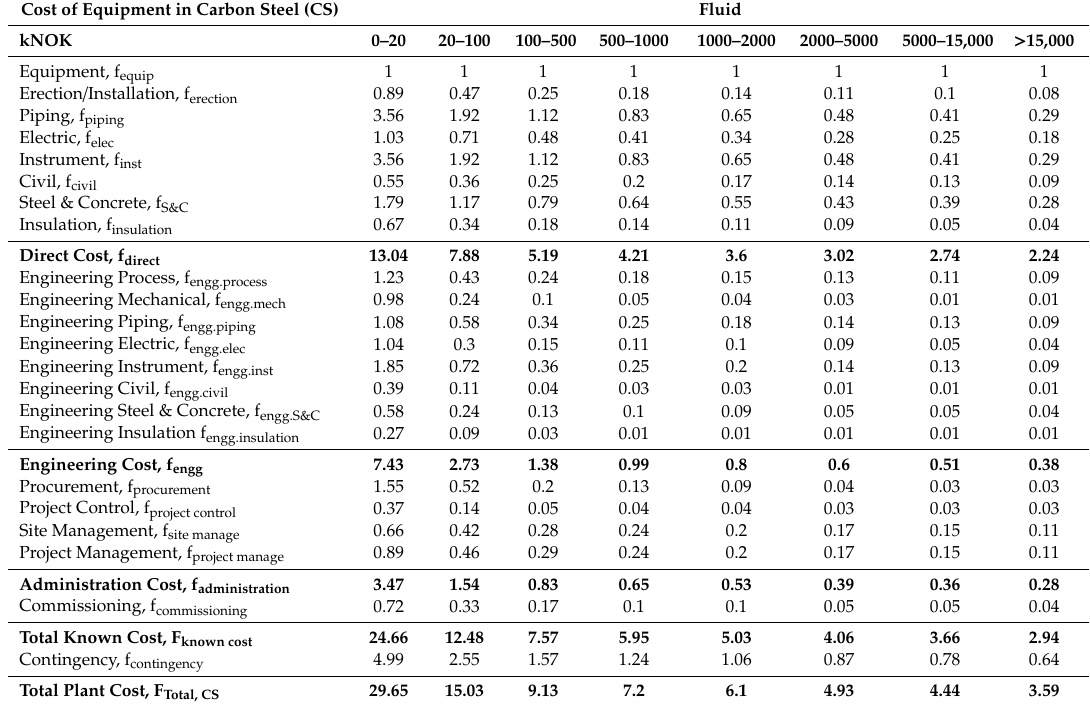
Table A1. EDF Installation factor sheet for fluid process plants prepared by Nils Henrik Eldrup (2018). Cost of Equipment in Carbon Steel